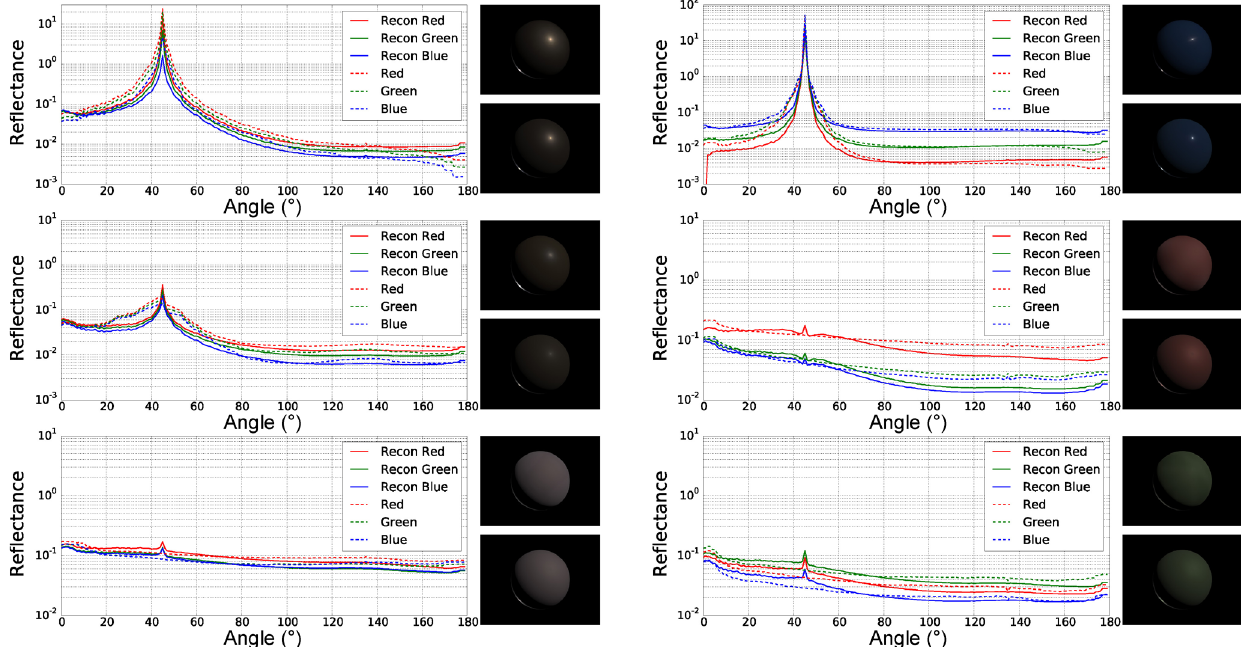
Fig. 9 Reconstructed BRDFs for alum-bronze , fruitwood-241 , pink-fabric , blue-acrylic , pink-fabric2 , and green-latex from the MERL BRDF database. Each graph compares the reconstructed BRDF (solid line) to the ground truth (dashed line). Each line represents the transition in the BRDF value when the incident light is at 135 ◦ and the viewpoint is located on the same plane as the incident light. The rendered sphere images have a front light at [1 , 1 , 1] and a back light at [ − 1 , − 1 , 3]. Above: rendered using ground truth. Below: rendered using reconstructed BRDFs.